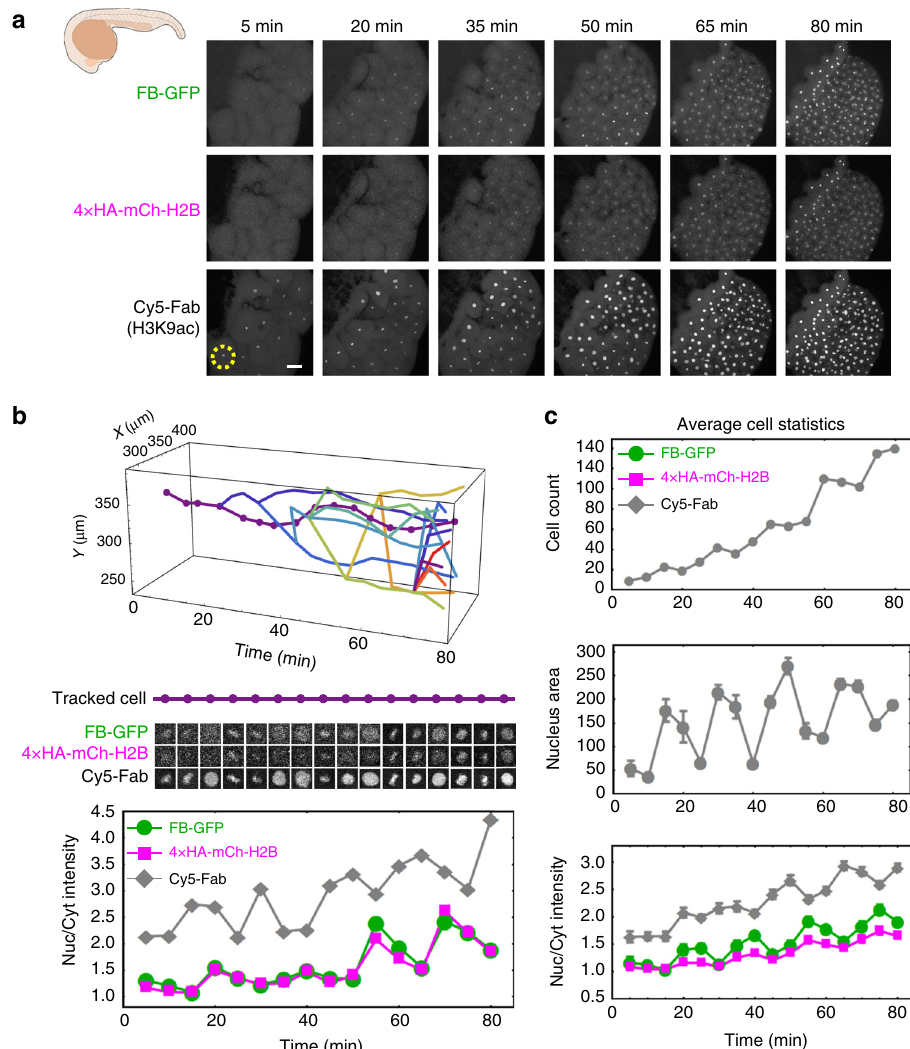
Fig. 9 Monitoring HA-tagged proteins in zebra fi sh embryos. a Max-projection images from a zebra fi sh embryo with frankenbody (FB-GFP) and 4 × HA- mCh-H2B. Cy5-Fab labels nuclear histone acetylation as a positive control. b A nuclei (dash circle in a ) and its progeny tracked in development. The nuclear to cytoplasmic ratio (Nuc/Cyt) from FB-GFP (green circles), HA-H2B-mCh (magenta squares), and Fab (gray diamonds) in the parental nuclei (dotted line). c Cell count (top), average nuclear area (units of pixel 2 with one pixel = 662 nm, middle) and Nuc/Cyt ratios for all tracked nuclei. See also Supplementary Figs. 7, 8 and Supplementary Movies 10, 11. Two embryos in two independent experiments. Error bars, SEM. Scale bar, 50 mm. Source data are provided as a Source Data fi